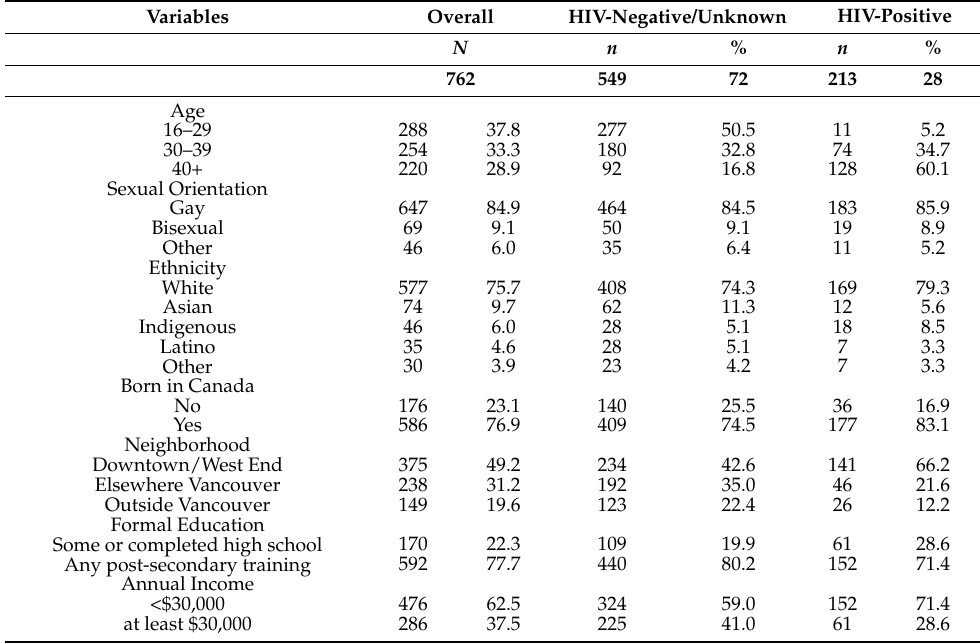
Table 1. Baseline participant-level descriptors of gbMSM in Metro Vancouver, stratified by self- reported HIV